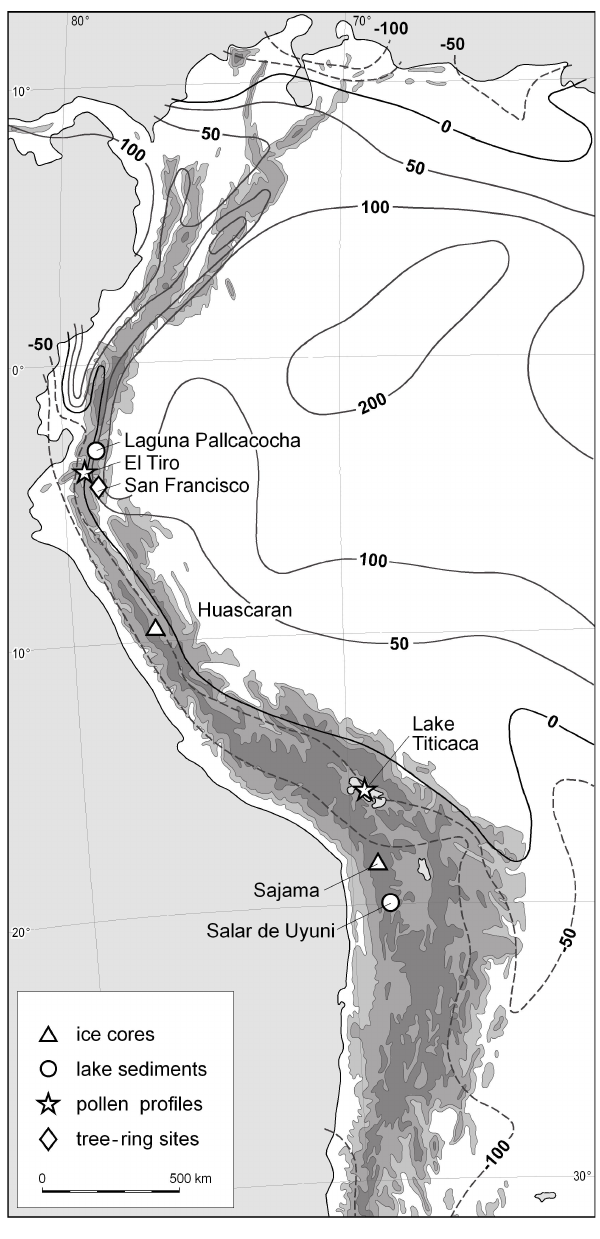
Fig. 1. Mean climatic water balance (in cm; from Henning and Henning, 1984, modified) and location of selected palaeoclimatic study sites along the Andes dealt in the